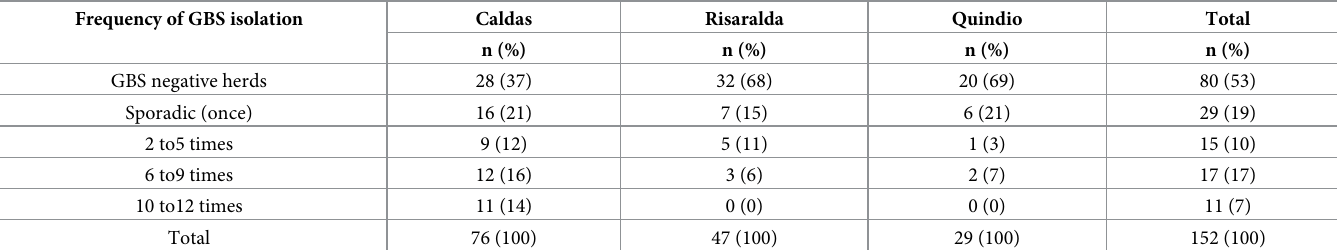
Table 2. Frequency and proportion n (%) of Streptococcus agalactiae (Group B Streptococcus, GBS) isolation by provinces. Frequency of GBS